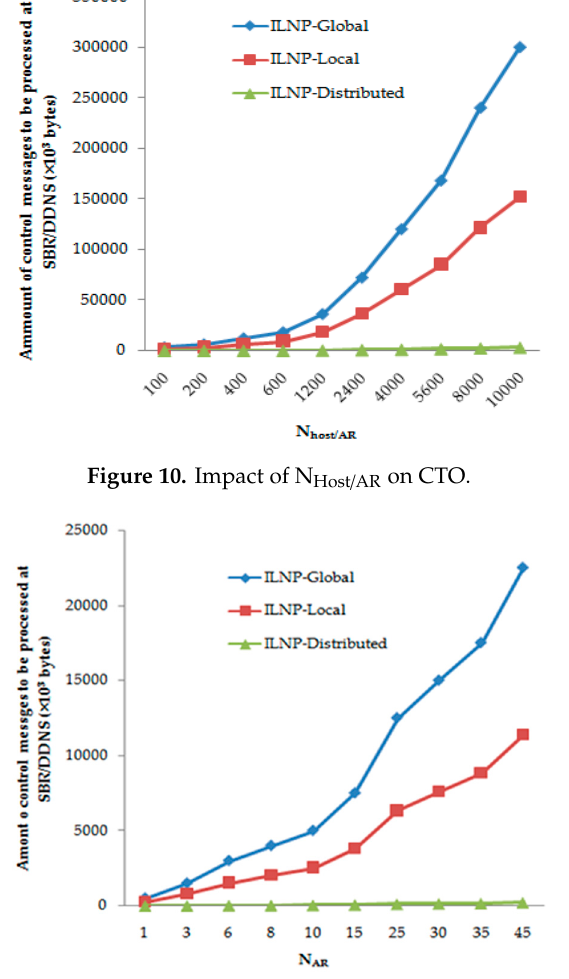
Figure 11. Impact of N AR on